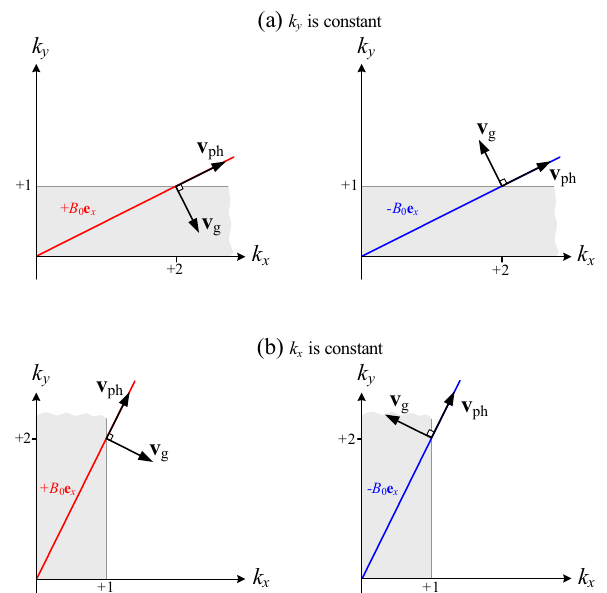
constant ) of SMPs at a flat magnetized electron gas-vacuum interface, Figure 5. Iso-frequency curves (ω = as obtained from Eq. (9) corresponding to the labeled points in Fig. 3, for figures). ( a ) k y is constant. ( b ) k x is constant. It is clear that the vectors v ph and v g are always perpendicular, and both are in the xy -plane. So the outer product of these two vectors always points in the v B 0 e x ( B 0 e x ), the outer product v ph for g points in the electron plasma (vacuum) + − ×